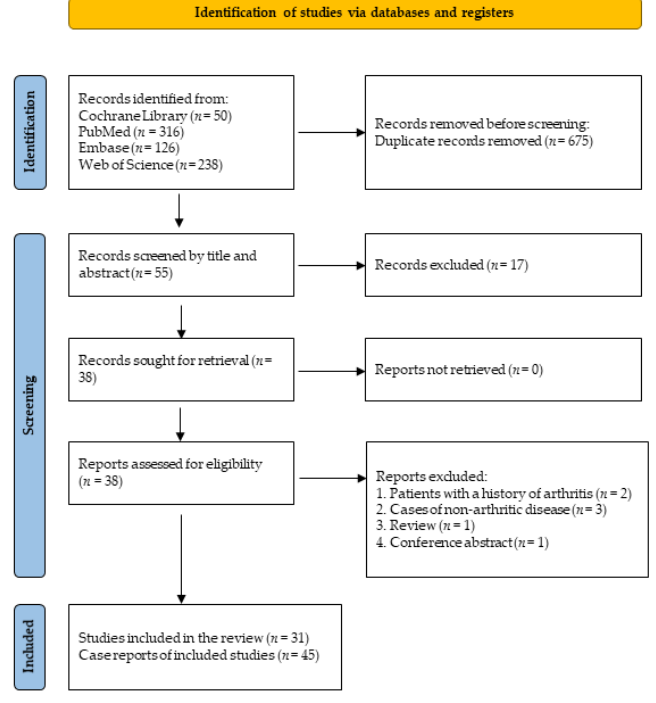
Figure 1. PRISMA flow diagram.